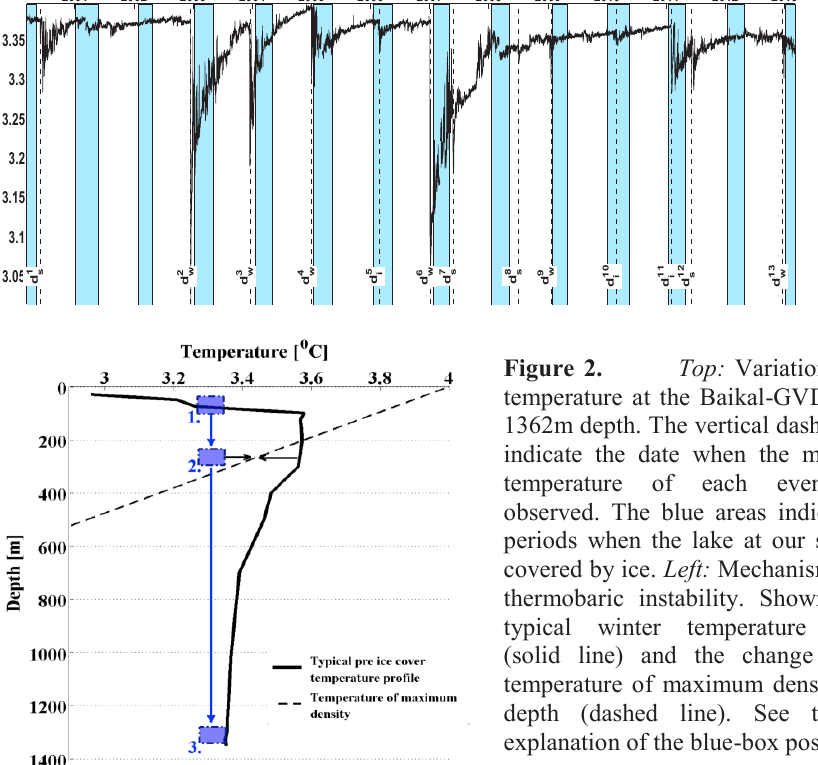
Figure 2. Top: Variation of the temperature at the Baikal-GVD site at 1362m depth. The vertical dashed lines indicate the date when the minimum temperature of each event was observed. The blue areas indicate the periods when the lake at our site was covered by ice. Left: Mechanism of the thermobaric instability. Shown are a typical winter temperature profile (solid line) and the change of the temperature of maximum density with depth (dashed line). See text for explanation of the blue-box